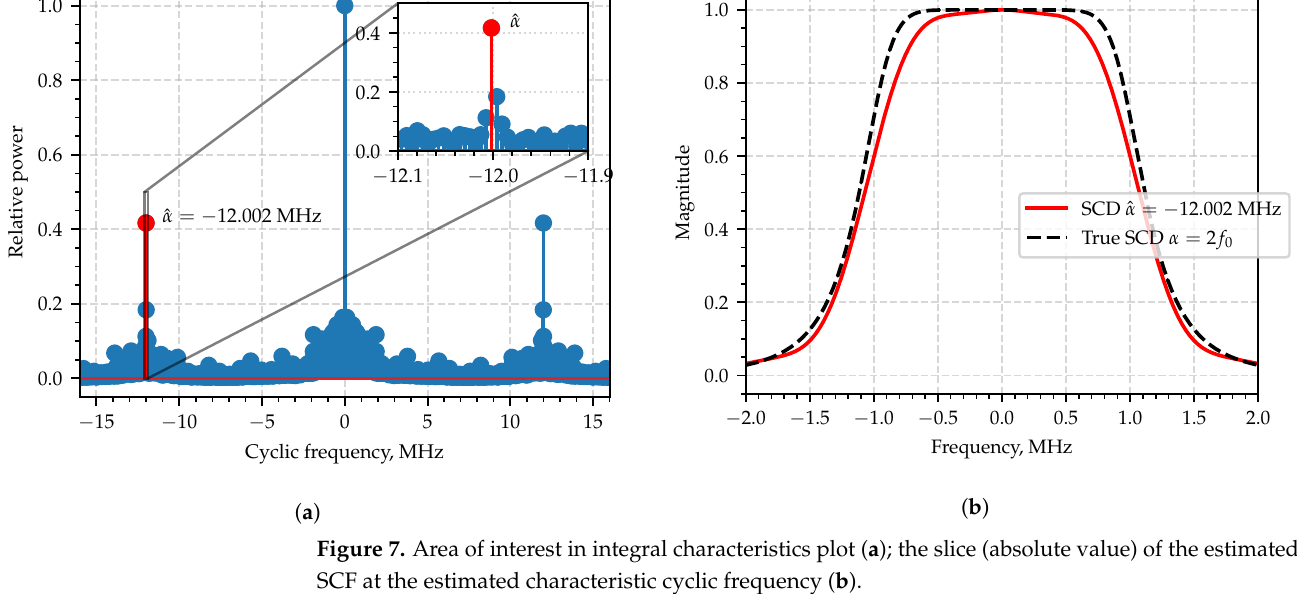
Figure 7. Area of interest in integral characteristics plot ( a ); the slice (absolute value) of the estimated SCF at the estimated characteristic cyclic frequency ( b